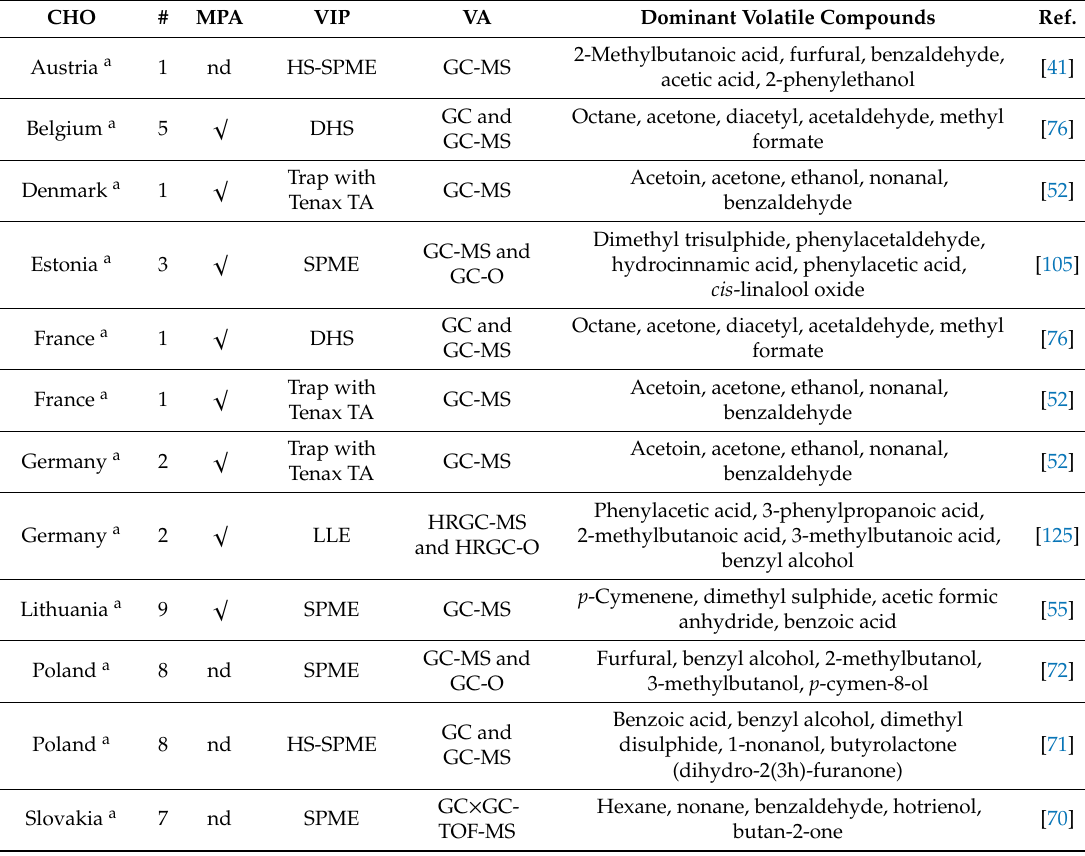
Table 15. Rape honey’s main volatiles, with reference to the country of origin, number of samples, isolation and analysis procedures and five main volatile components. Unless otherwise specified, the honeybee type was A. mellifera